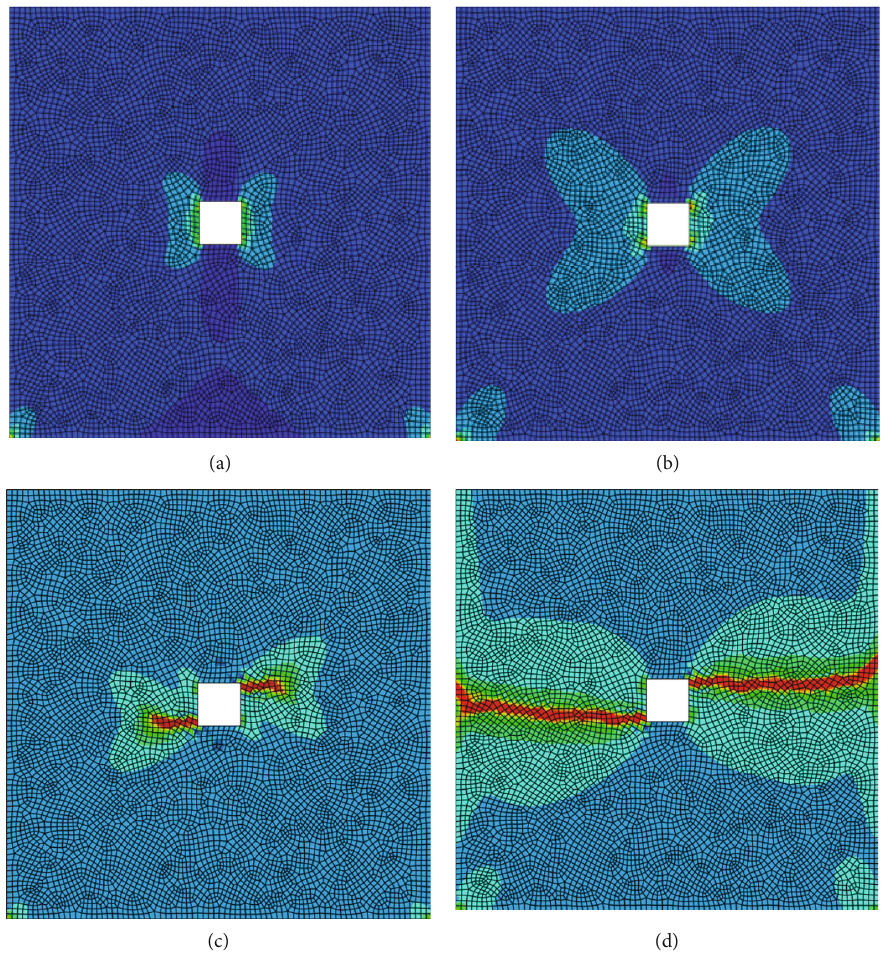
Figure 8: The result of crack propagation. (a) Crack initiation stage. (b) Crack initiation stage. (c) Crack development stage. (d) Crack penetration